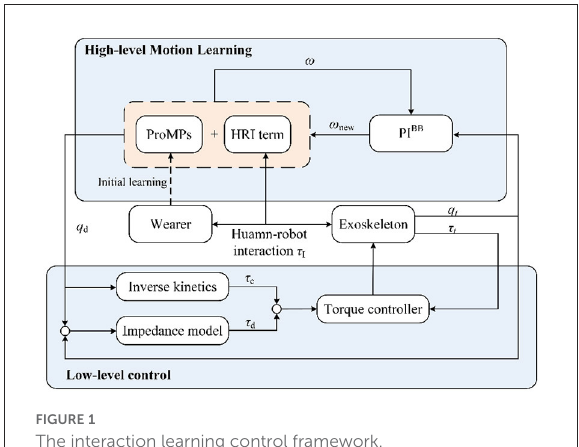
FIGURE1 The interaction learning control